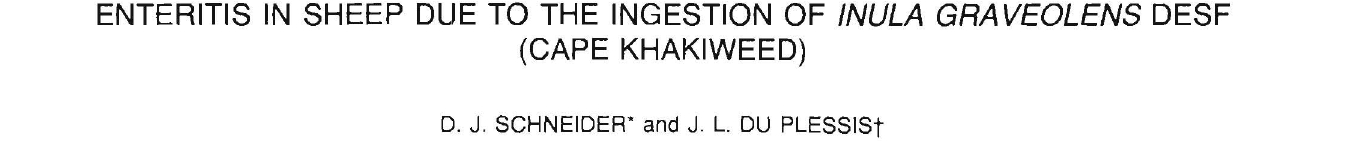
Fig. 2. Scanning electton phot9micrograph 01 the pappus 01 /. graveo/ens with jtS'bristies x 75.